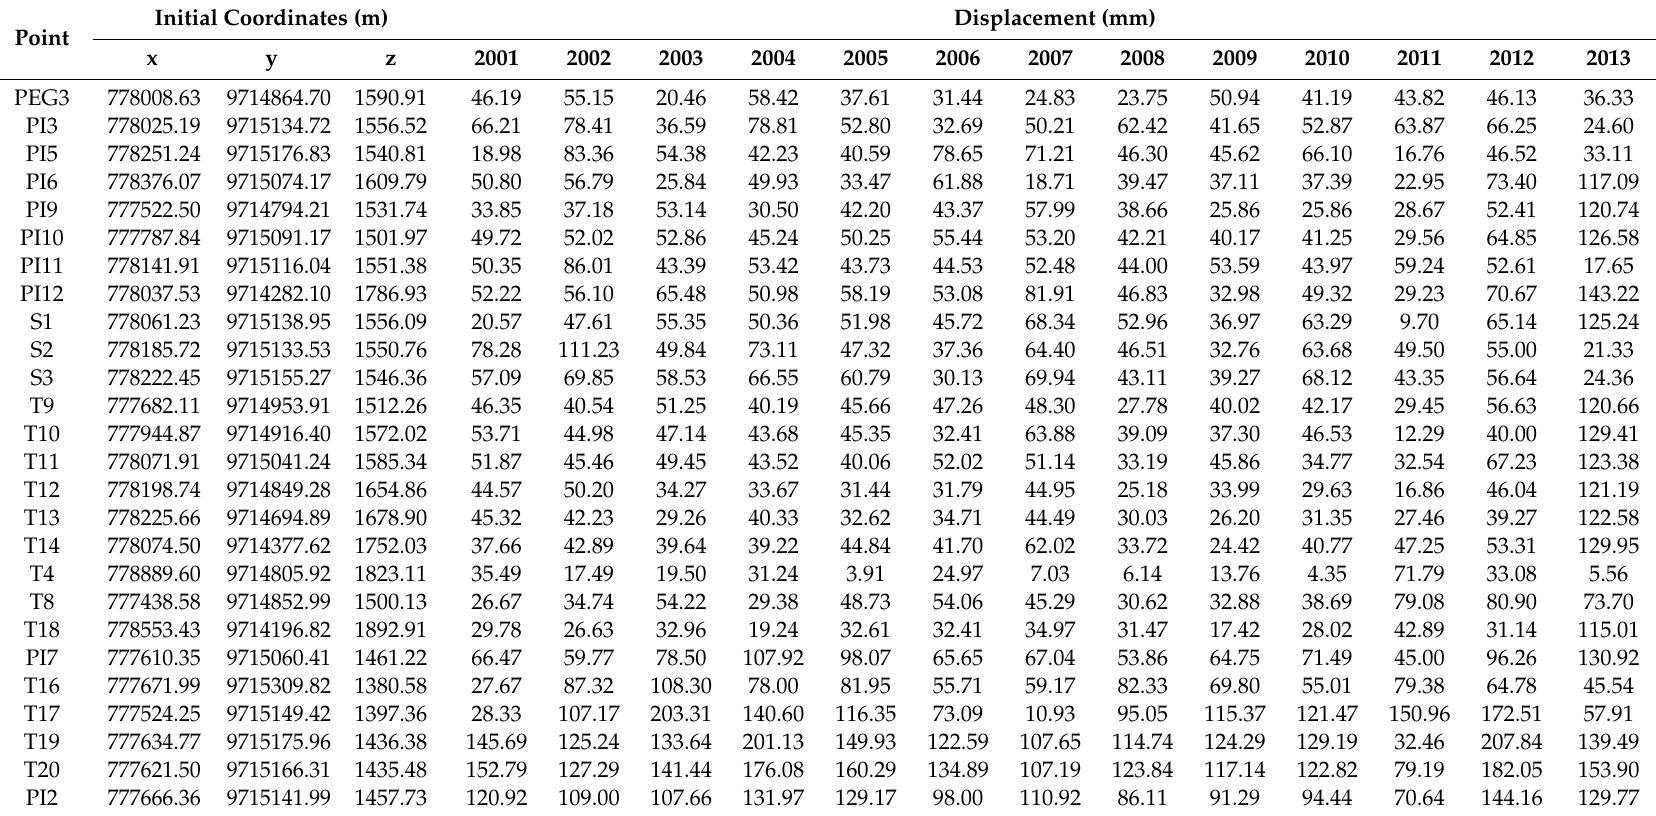
Table A1. The initial coordinates and horizontal displacement detected by 26 fixed points in Guarumales from 2001 to